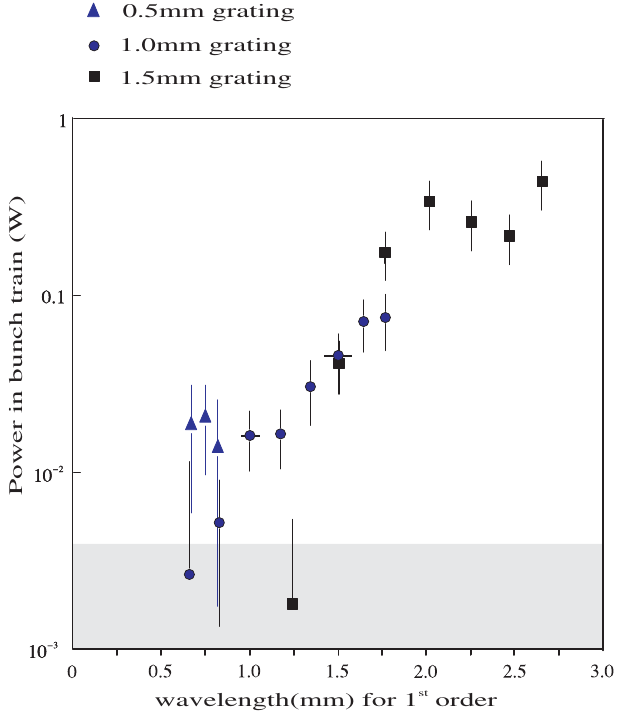
FIG. 7. (Color) Measured Smith-Purcell power versus 1st order wavelength from three different gratings. Beam energy was 45 MeV and bunch spacing 1 ns. Points in the shaded area have been excluded from the analysis. See text for